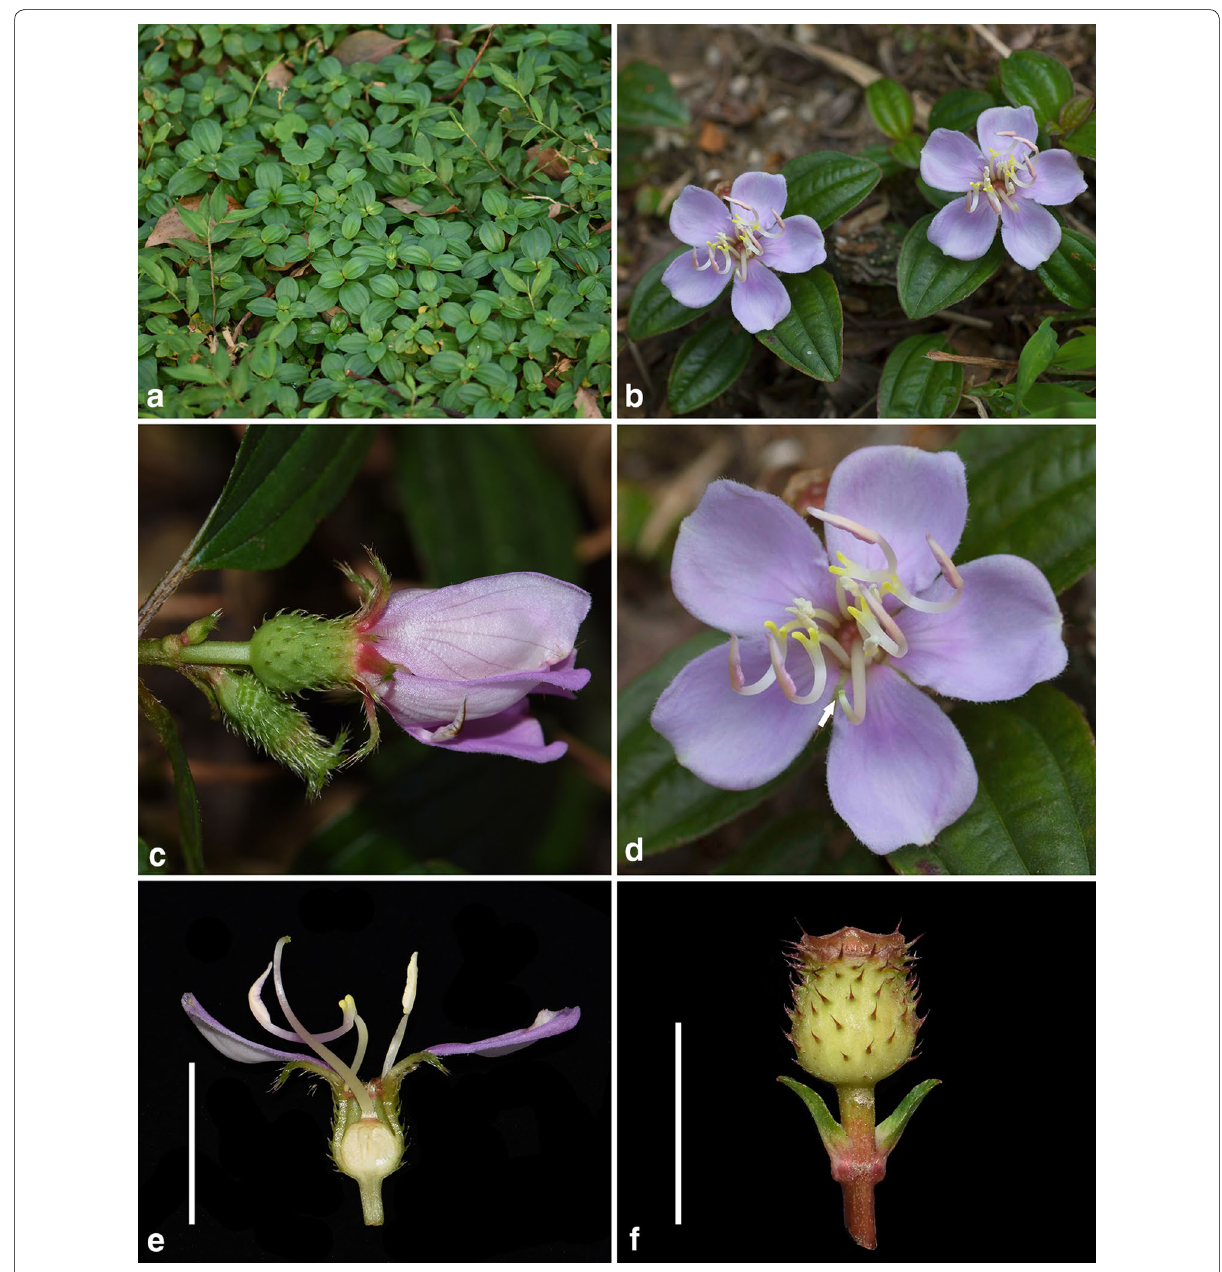
Fig. 8 Melastoma dodecandrum Lour. a Habit; b flowering branches; c inflorescence; d flower, arrow indicated the position of stigma; e longitudinal section of a flower, scale bar 10 mm; f young fruit showing the spreading hairs, scale bar 10 mm (b and d photographed by Ms. Xiaolan